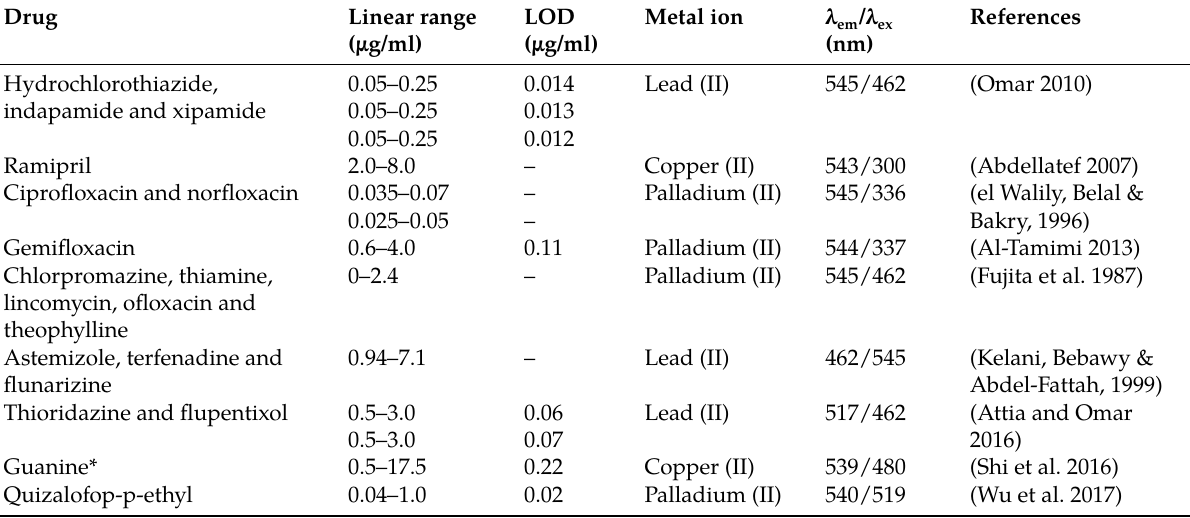
Table 5: Reported fluorescence quenching methods based on ternary complex formation with eosin Y in the presence or absence of methyl